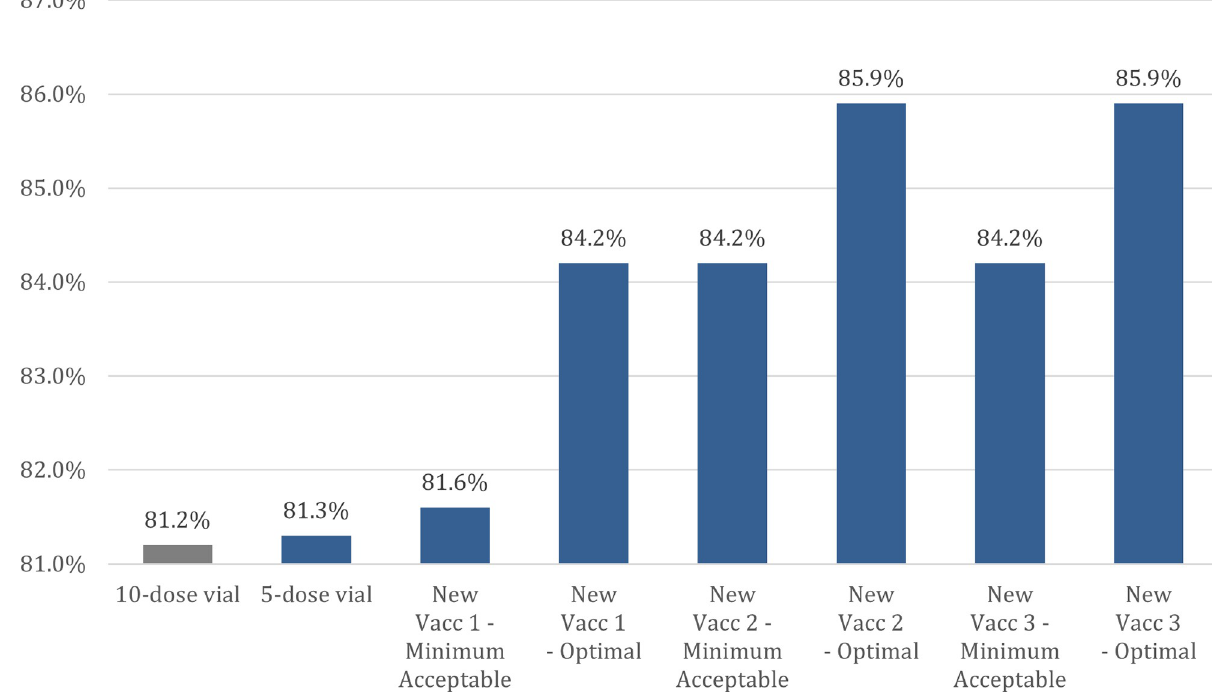
PLOS ONE | https://doi.org/10.1371/journal.pone.0283977 April 5,